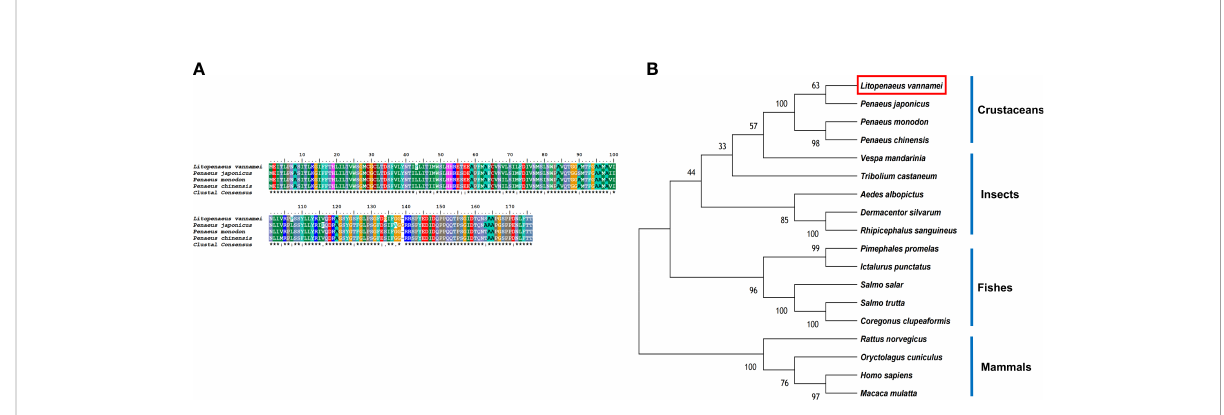
FIGURE 4 (A) Multiple alignments of deduced amino acids of LV-AT 1 R protein and its homologs. Species names are listed on the left side. (B) The phylogenetic tree shows relationships between the AT 1 R protein of L. vannamei (red rectangle) and those of other organisms. Species names are listed to the right of the